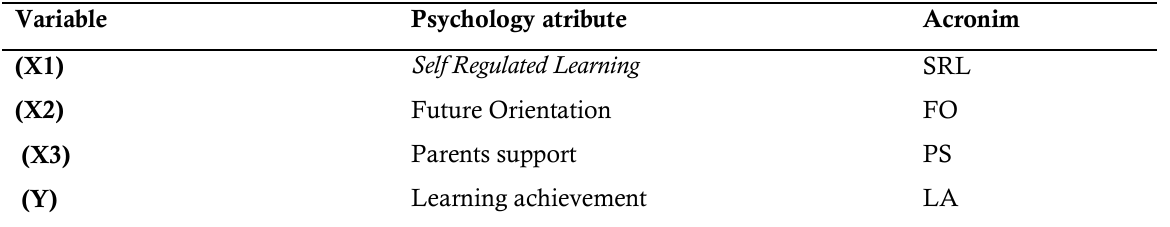
Table 1. Identification of research